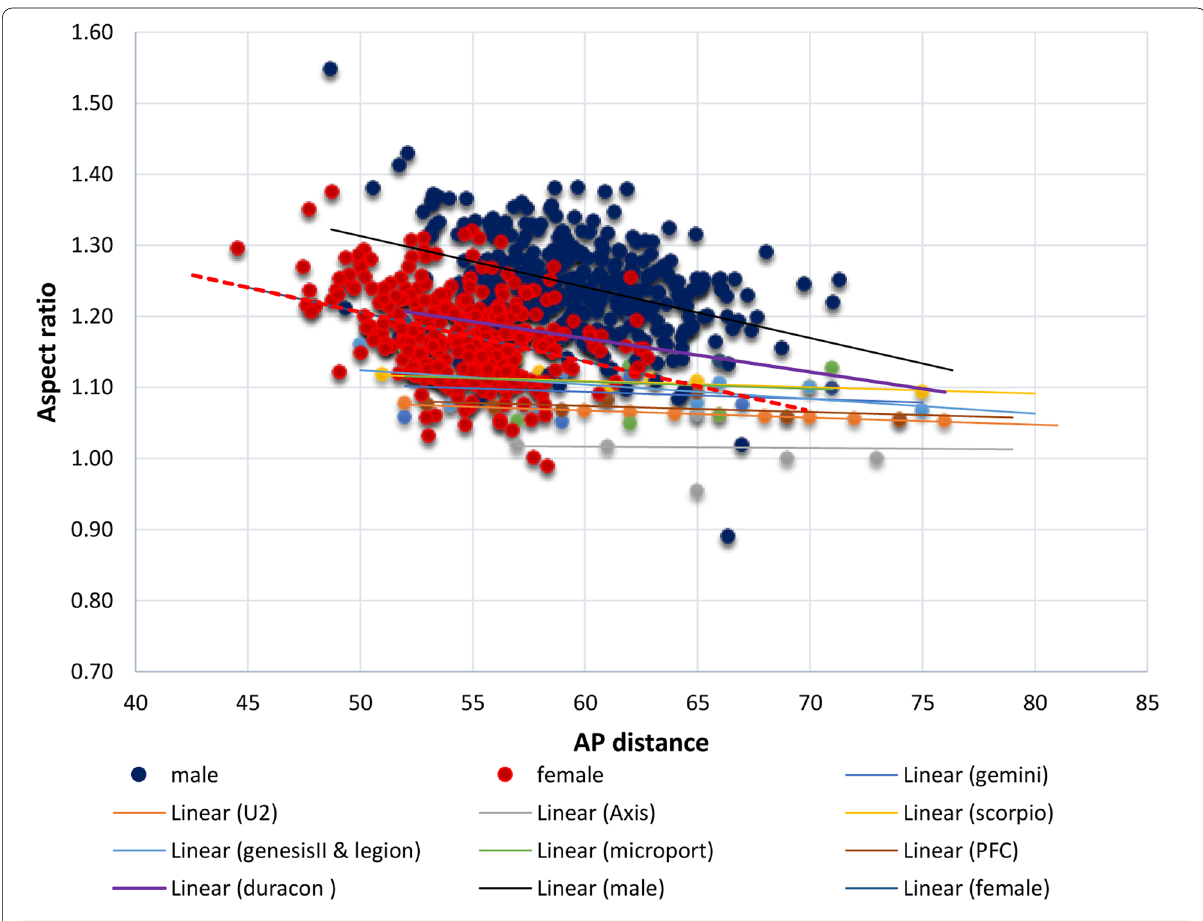
Fig. 7 The aspect ratio to AP distance of the femoral